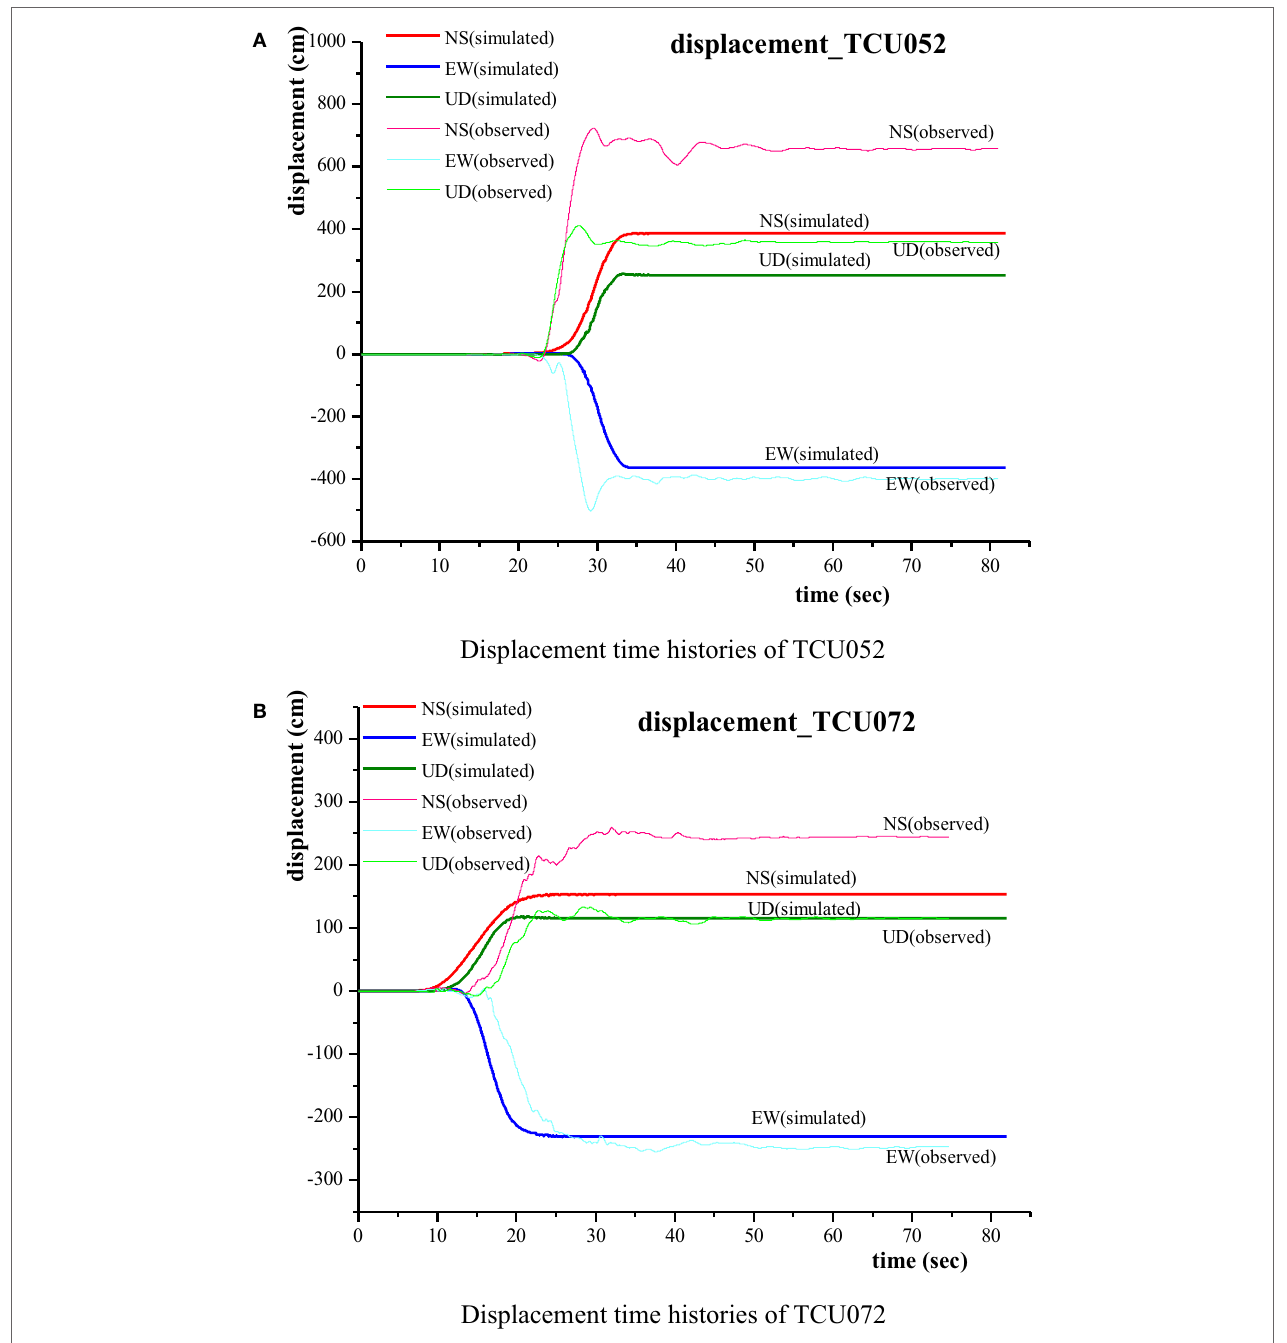
FigUre 14 | Observed (thick line) and simulated (bold line) waves for the displacement time histories, along the ns-, eW-, UD-direction for (a) TcU052 and (B) TcU072, respectively